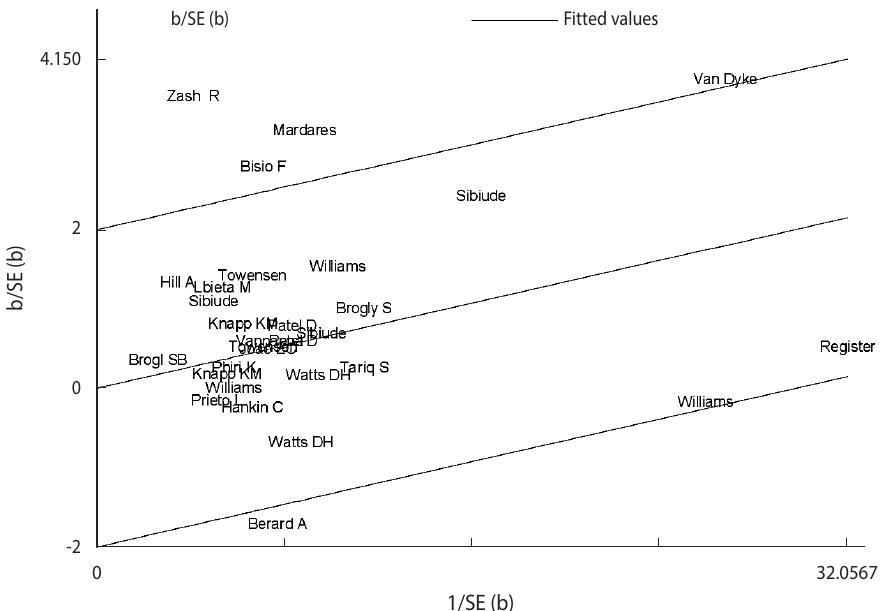
Figure 3. Galbraith plot for the log odds ratio of congenital anomalies in patients who received antiretroviral therapy (ART) versus ART-naïve individuals. b, beta; SE, standard